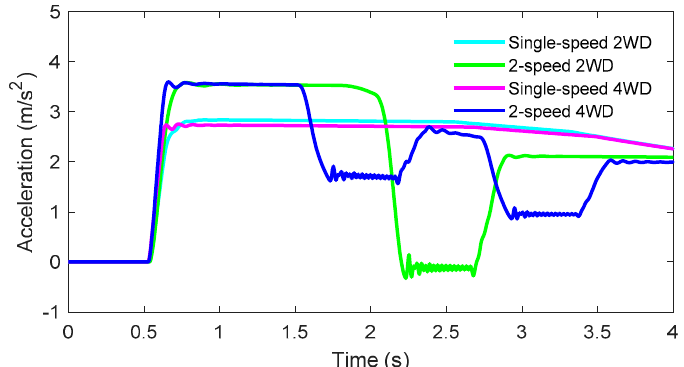
Figure 9. Longitudinal vehicle acceleration profiles for the four EV layouts, during a tip-in test including gearshift actuation for the layouts with 2-speed transmissions.